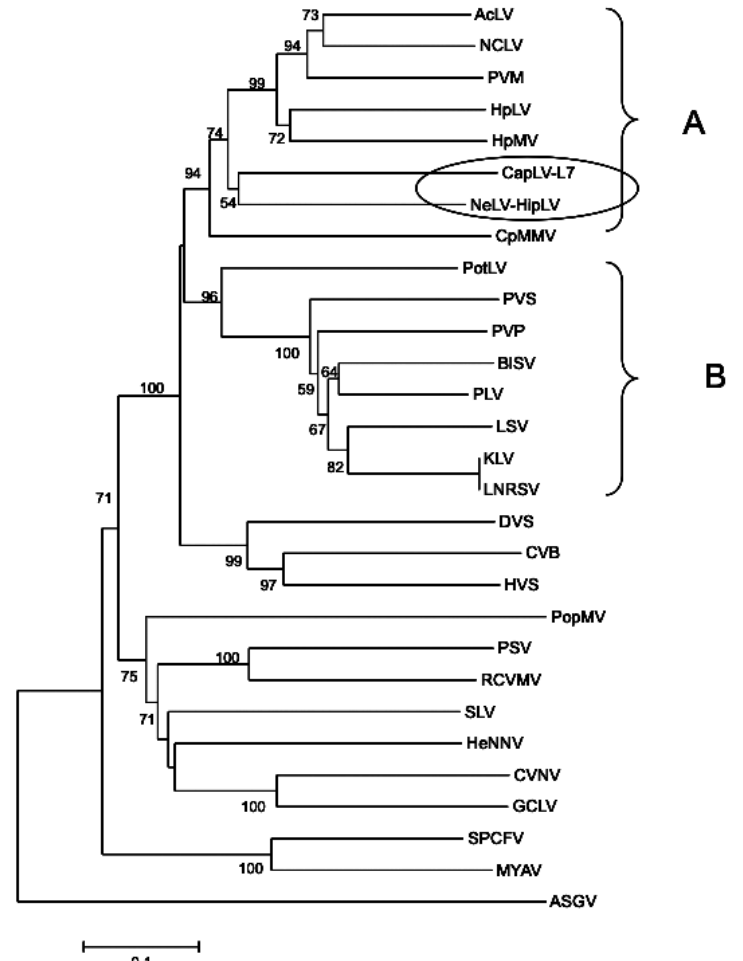
Figure 2. Phylogenetic relationships for amino acid partial sequences of the CP gene (ORF5) of the caper carlavirus (CapLV-L7) and other carlaviruses. The tree was bootstrapped using 10,000 replications. See text for full virus names and Genbank accession numbers of their nucleotide